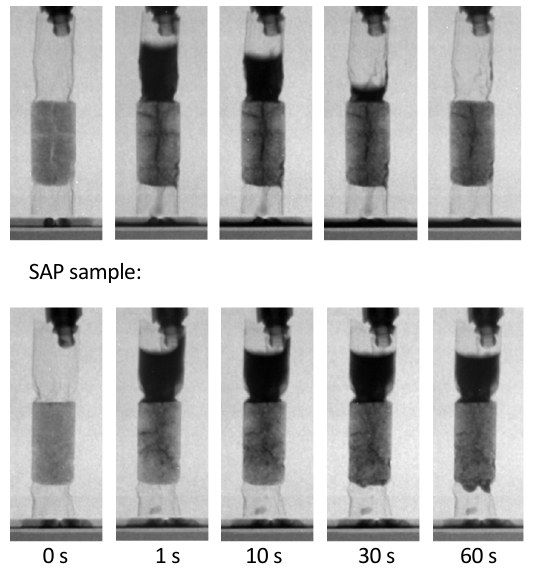
Figure 1. Cracked specimens containing 1 m% SAP particles are able to withstand a water head due to their swelling effect.